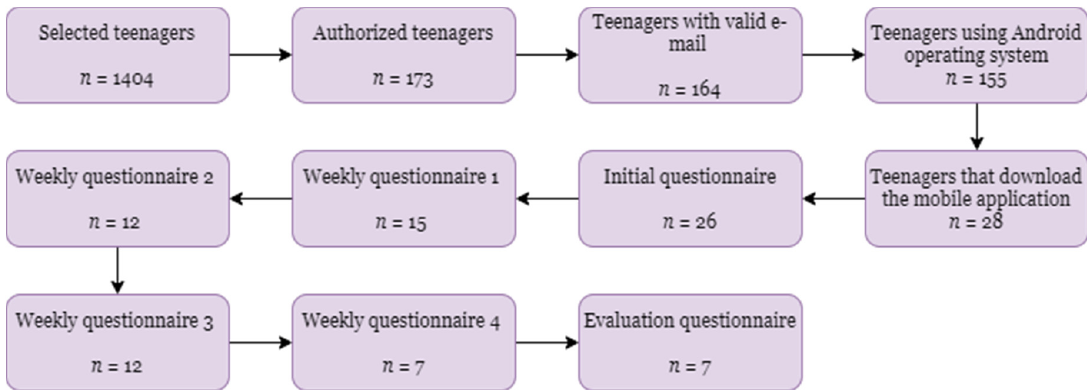
Figure 2. Evolution of the number of teenagers during the study.